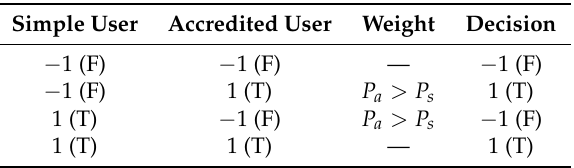
Table 3. Decision-making Pa > Ps.